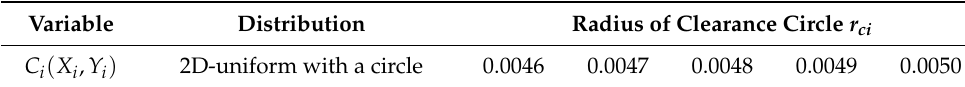
Table 4. Distributions of random variables of clearance circle.